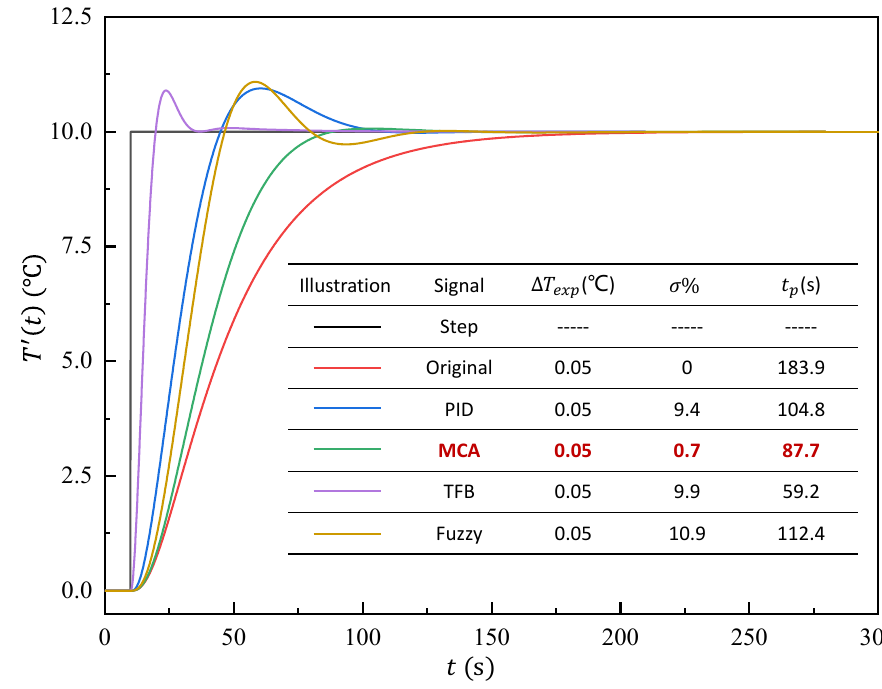
𝑡𝑡 (s) Figure 7. System response under different